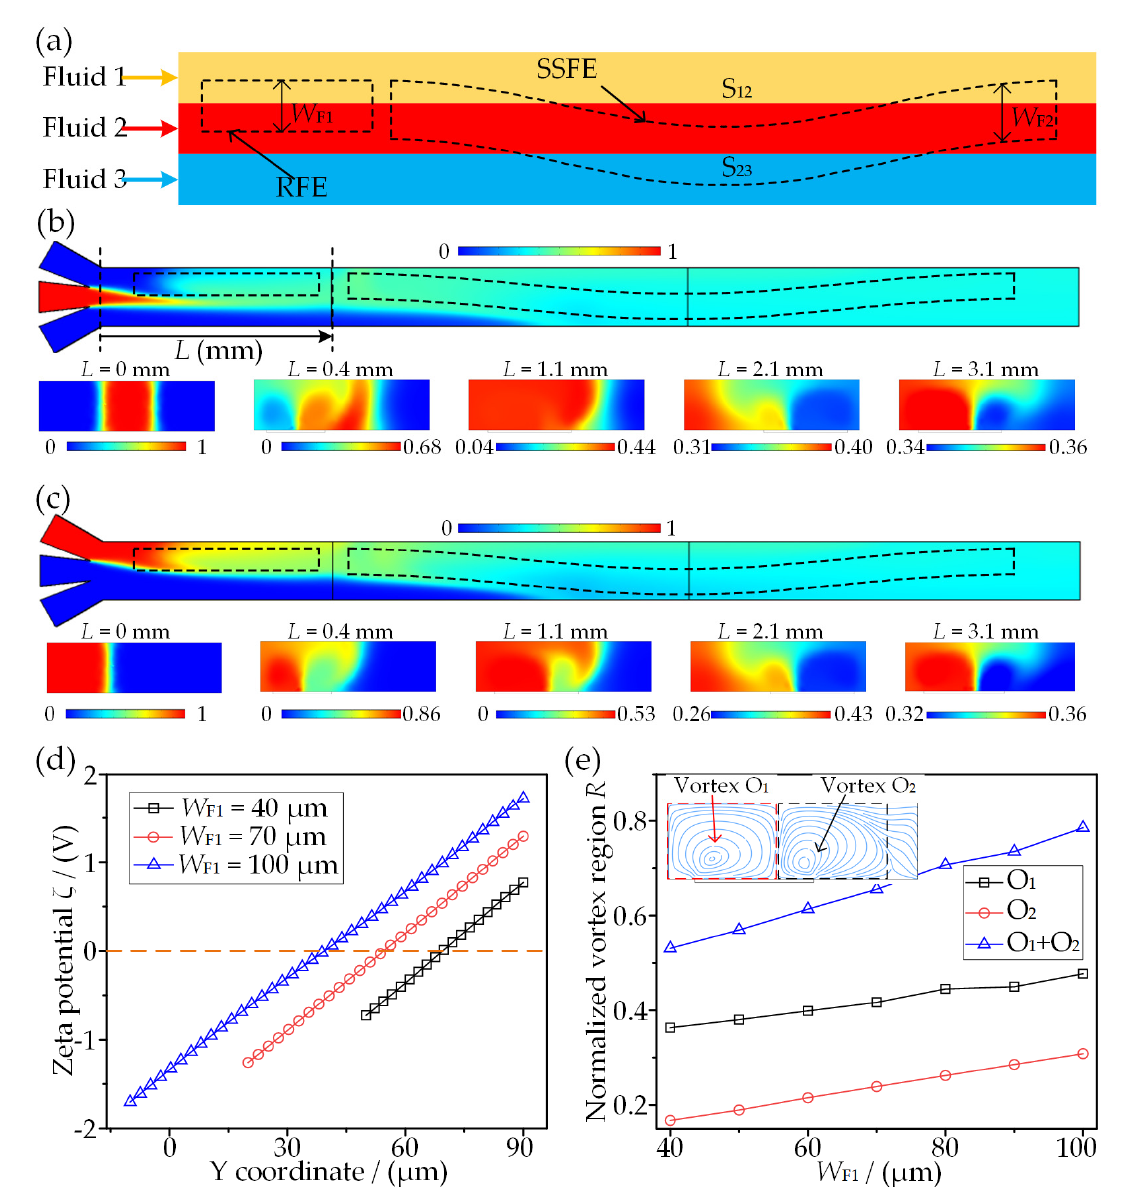
Figure 8. Influence of the rectangle floating electrode (RFE) on the performance of sequential micromixer. ( a ) Configuration of RFE and SSFE for sequential multi-fluid mixing. ( b ) Evolution of concentration distribution for middle fluid. ( c ) Evolution of concentration distribution for side fluids. ( d ) Variations of zeta potential on RFE. ( e ) The microvortex variation above RFE with different values of electrode width W F1